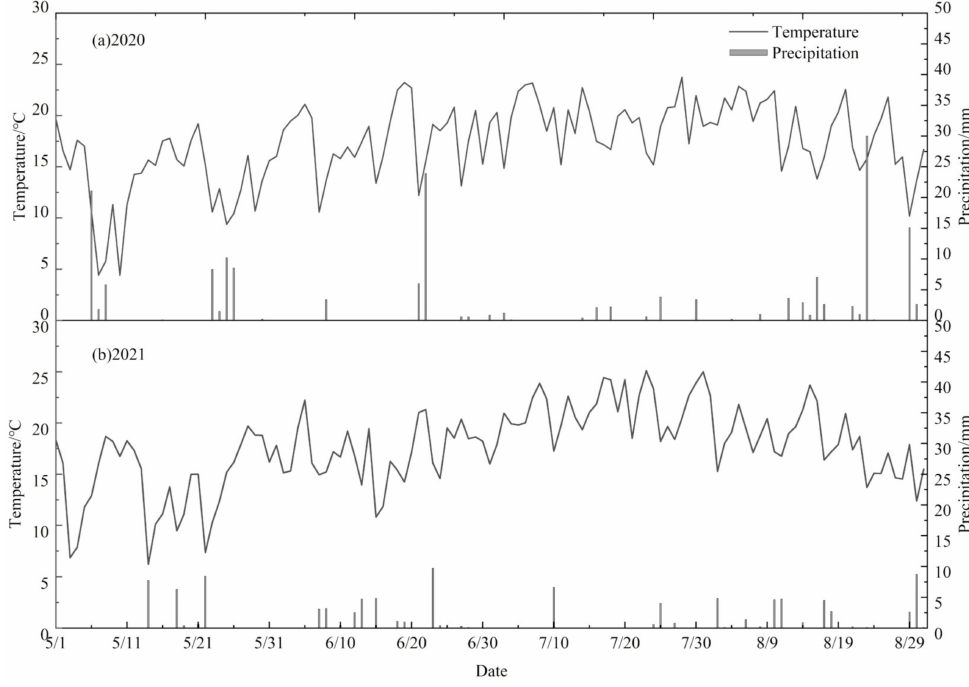
Figure 1. Dynamics of temperature and rainfall during the pumpkin growing seasons: ( a ) 2020; ( b ) 2021.